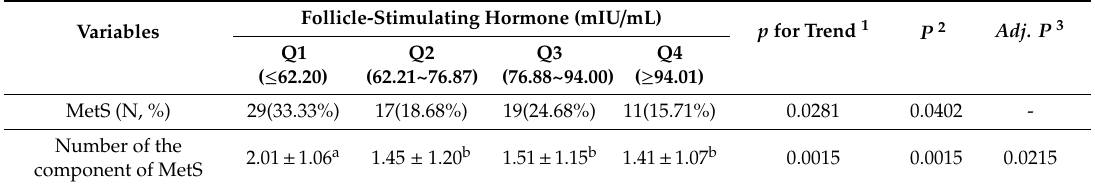
Table 3. Comparisons of metabolic syndrome and number of its components by quartiles of follicle-stimulating hormone.